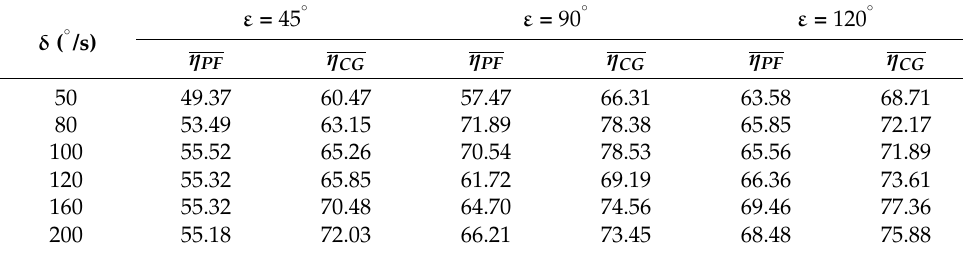
Table 2. Average balance efficiencies η PF and η CG of EG under 18 vibration conditions (%).